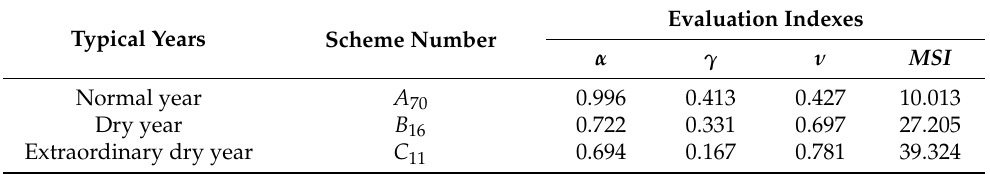
Table 4. Coordination schemes for different typical